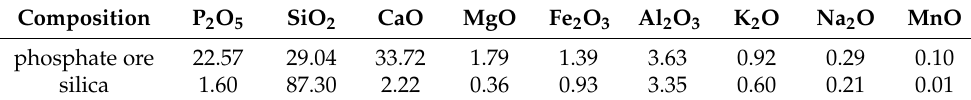
Table 1. Chemical compositions of the phosphate ore and silica (mass fraction, wt %).